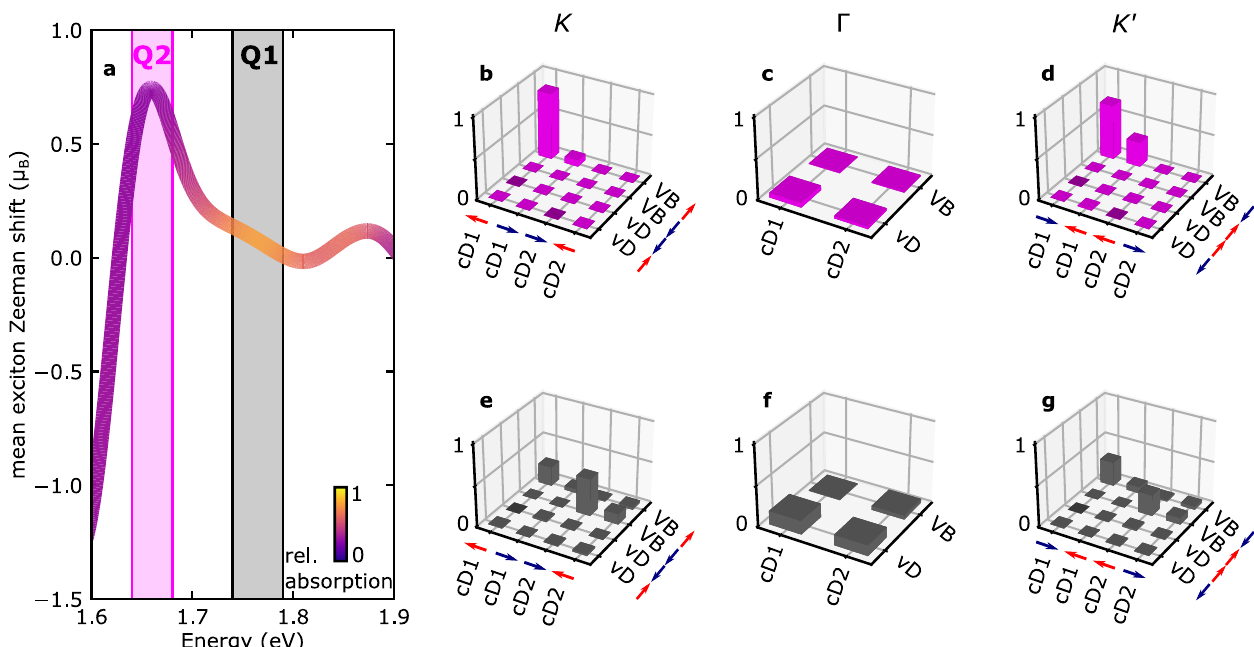
Fig. 5 GW-BSE results for optical absorption, exciton Zeeman splitting, and transition contributions. a Mean exciton Zeeman splitting as a function of excitation energy. The colorcode on the line represents the absorption strength at each energy. b – d Electron-hole transitions contributing to excitons in the energy range associated with Q2, namely in the magenta shaded area in a . The electron bands (cD1 and cD2), as well as the hole bands (vD and VB) are illustrated in energetic order under the consideration of the lifted spin degeneracy at the K = K 0 -points. e – g Electron-hole transitions contributing to excitons in the energy range associated with Q1, namely in the gray shaded area in a . The transitions are shown for three selective k-points, K ( b , e ), Γ ( c , f ), and K 0 ( d , g